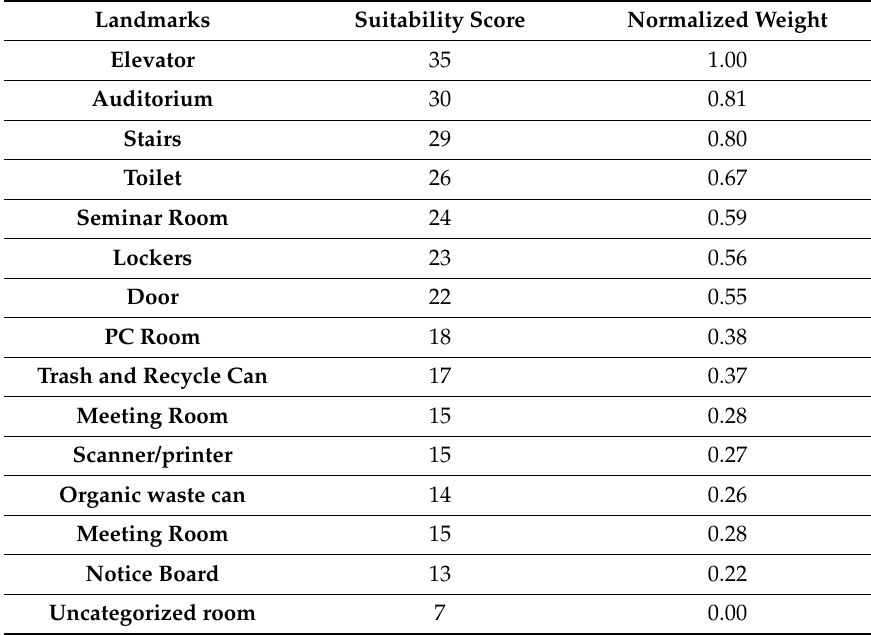
Table 2. Overall suitability scores and normalized weights of the selected landmarks.